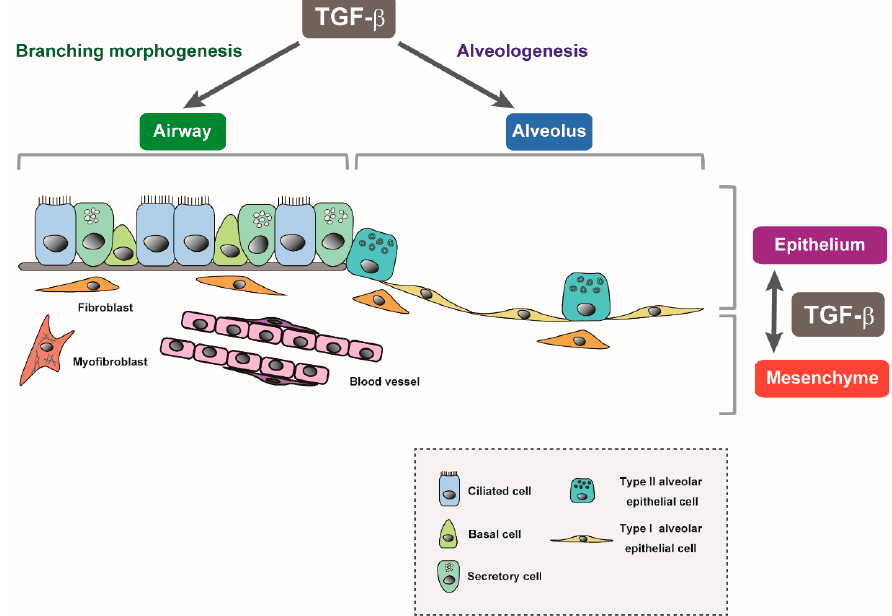
Figure 1. Structure of the airway and alveolus. TGF- β regulates epithelial-mesenchymal interactions and is crucial for branching morphogenesis and alveologenesis during